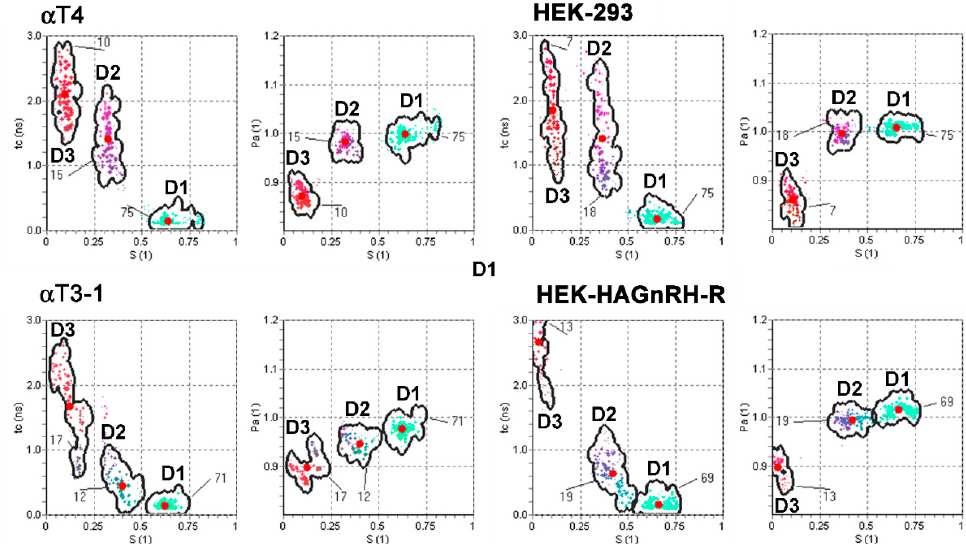
Figure 4. Effect of GnRH-R expression on the PM domain structure of pituitary gonadotrope and heterologous cell line. S- τ c (order parameter vs. rotational correlation time) and S-p A (order parameter vs. polarity correction factor) GHOST diagrams of EPR spectral parameters of motional modes of the spin probe in the PM of gonadotrope progenitors lacking endogenous GnRH-R ( α T4 cells), immortalized pituitary gonadotrope cell line ( α T3-1 cells), untransfected HEK-293 cells and HEK-293 cells stably expressing HA-tagged GnRH-R (HEK-HAGnRH-R). The red dots are the average values of the spectral parameters obtained from multiple runs of the HEO-optimization procedure, yielding the best fits to the experimental spectra. The boundaries of each group determine the interval in which the solutions can be obtained, and the numbers correspond to the proportion of each domain type (%). GHOST diagrams are representative of at least four independent experiments. Domain 1 (D1), domain 2 (D2), domain 3